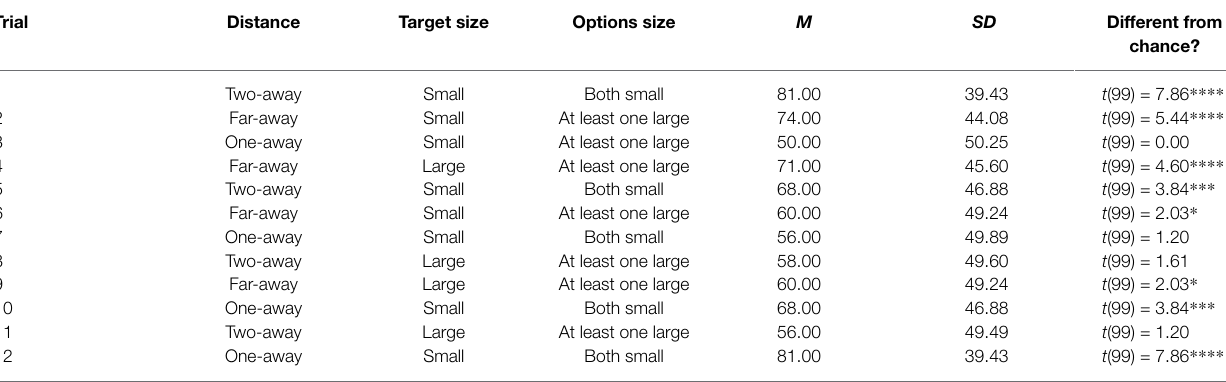
TABLE 1 | Descriptive statistics for children’s performance in the Point-to-X task, N = 100.